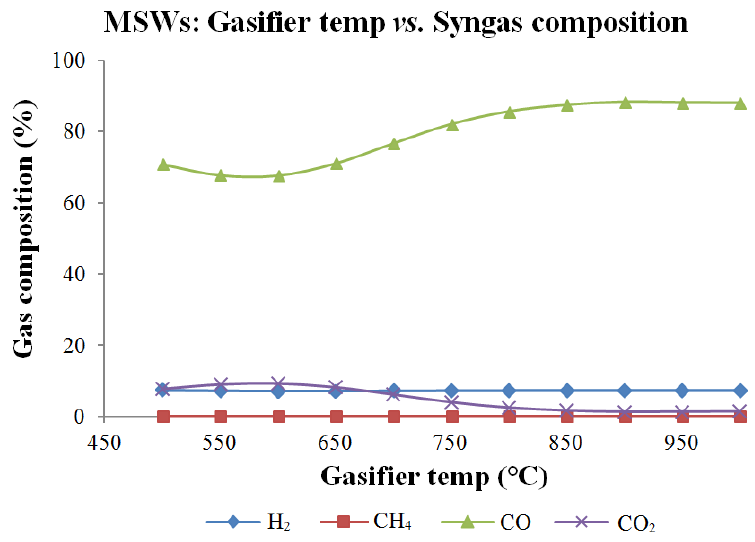
Figure 7. Effect of gasifier temperature for MSWs (air-fuel ratio: